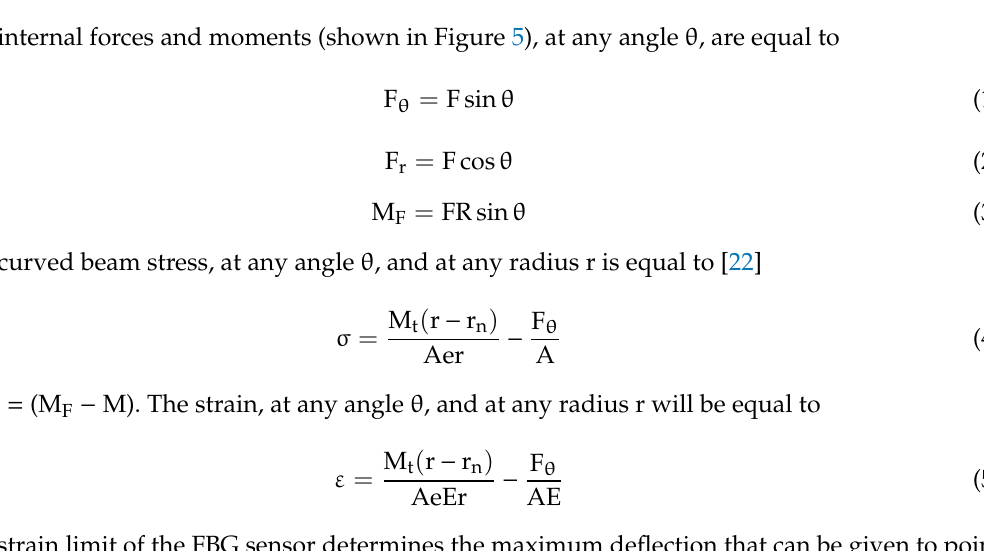
Figure 5. Plastic semicircular curved beam internal forces and moments.